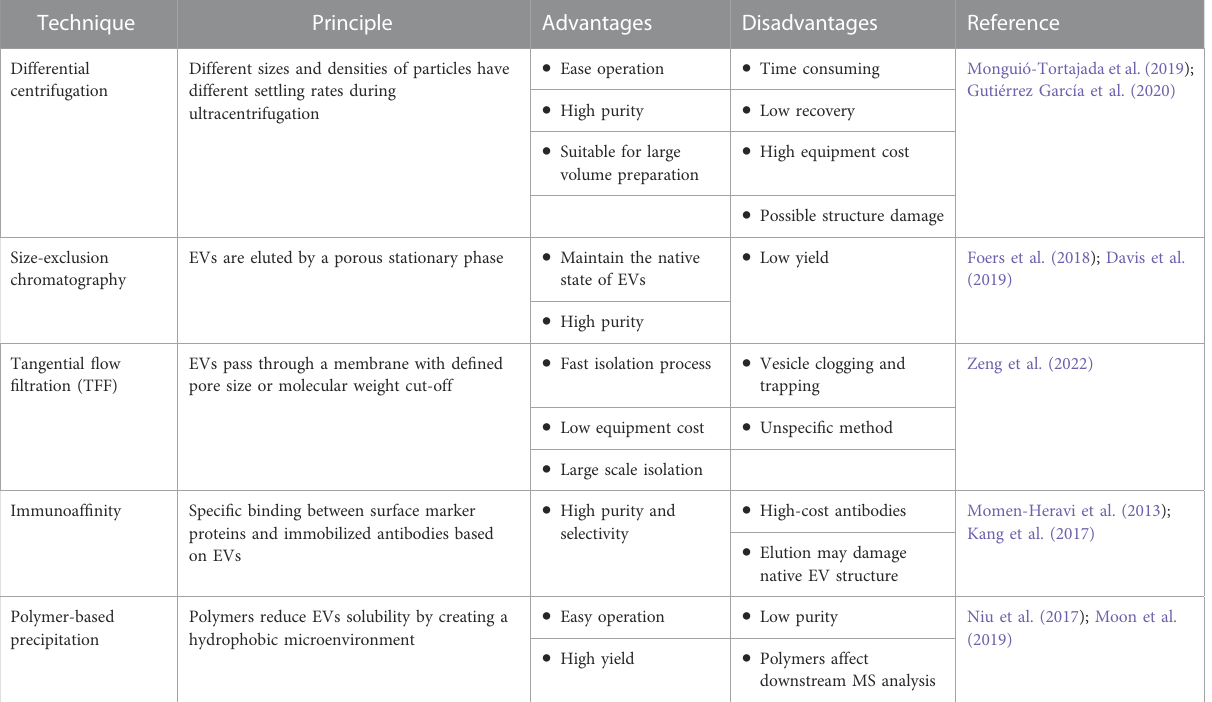
TABLE 1 Isolation and puri fi cation method of major